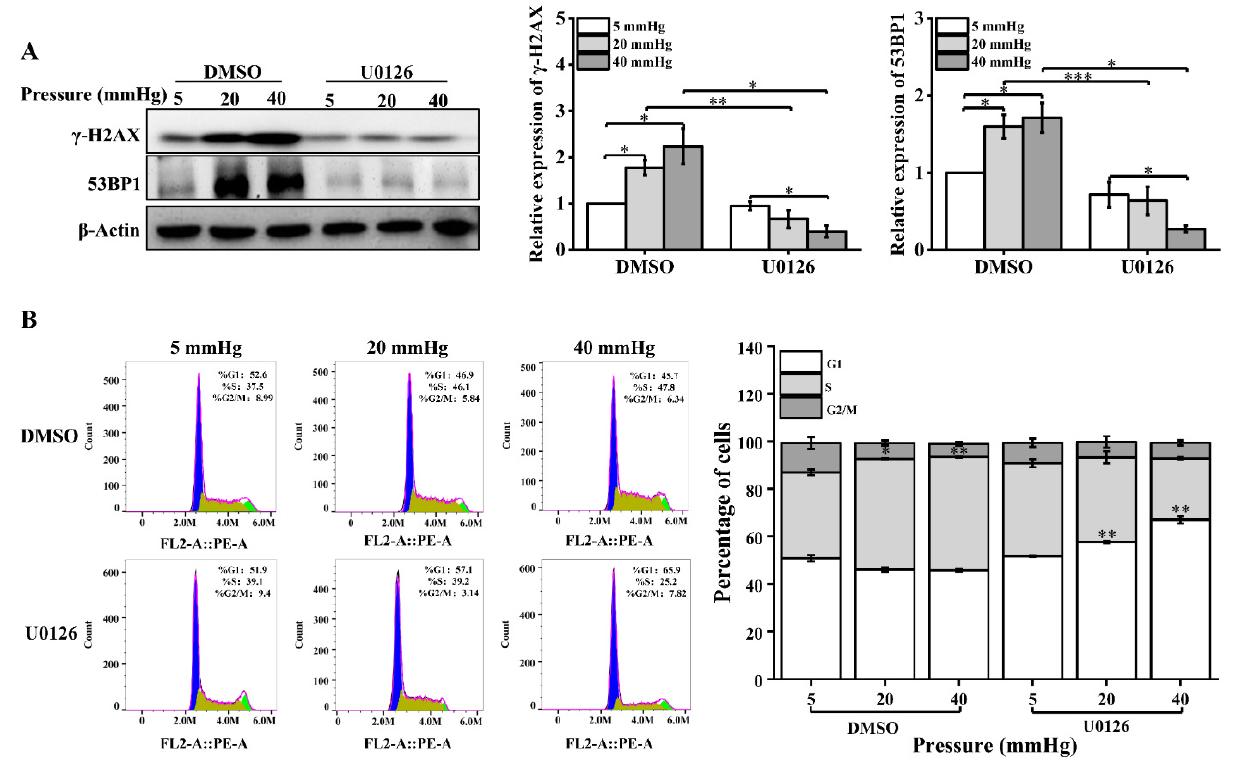
Figure 6. U0126 treatment causes downregulation of DNA repair proteins and cell-cycle changes in pressure-loaded hepatocytes: ( A ) DNA repair proteins in hepatocytes treated with U0126 (10 µM) were examined with Western blot and quantification data of the γ -H2AX and 53BP1 protein levels. The cells were exposed to pressure for 48 h; ( B ) cell-cycle distribution was analyzed using flow cytometry following U0126 treatment and pressure loading for 48 h. The images are representative of three independent experiments. The stacked bar graph indicates the percentage of cells at various stages of the cell cycle. Data are expressed as the mean ± SD. n = 3, * p < 0.05, ** p < 0.01, *** p < 0.001.